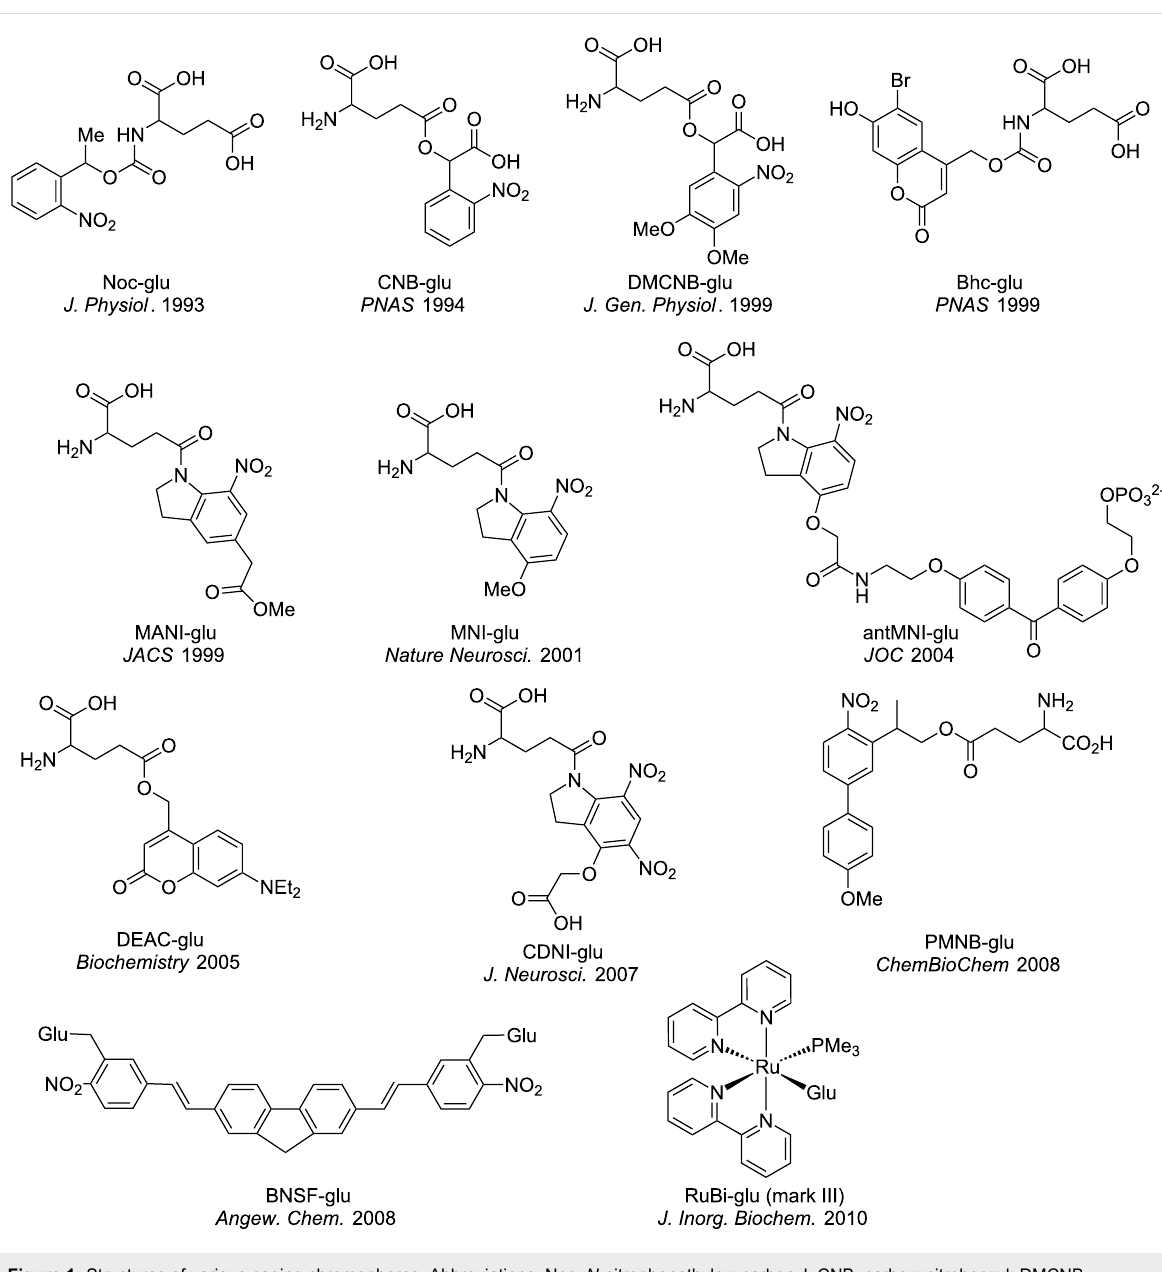
most of the original papers describing the development of the compounds, detailed pharmacology was described. In one report, the spontaneous miniature excitatory post-synaptic currents (EPSCs) were measured in the presence and absence of a probe when it was puffed at 10 mM concentration onto cultured hippocampal neurons [31]. The histograms of the ensemble averages were indistinguishable. The other examined whether MNI-Glu blocked the current evoked by puffer applica-